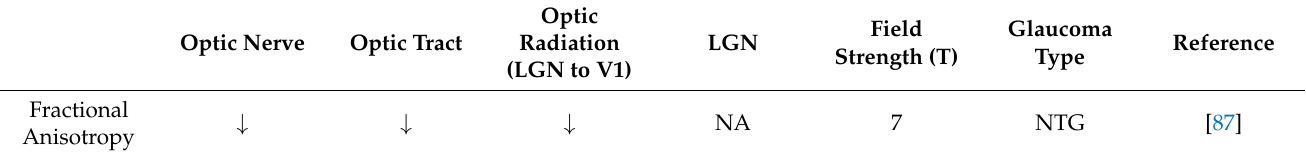
Table 3. Summary of DTI parametric changes across visual brain regions of glaucoma patients relative to healthy control subjects in selected articles. LGN: Lateral geniculate nucleus; V1: Primary